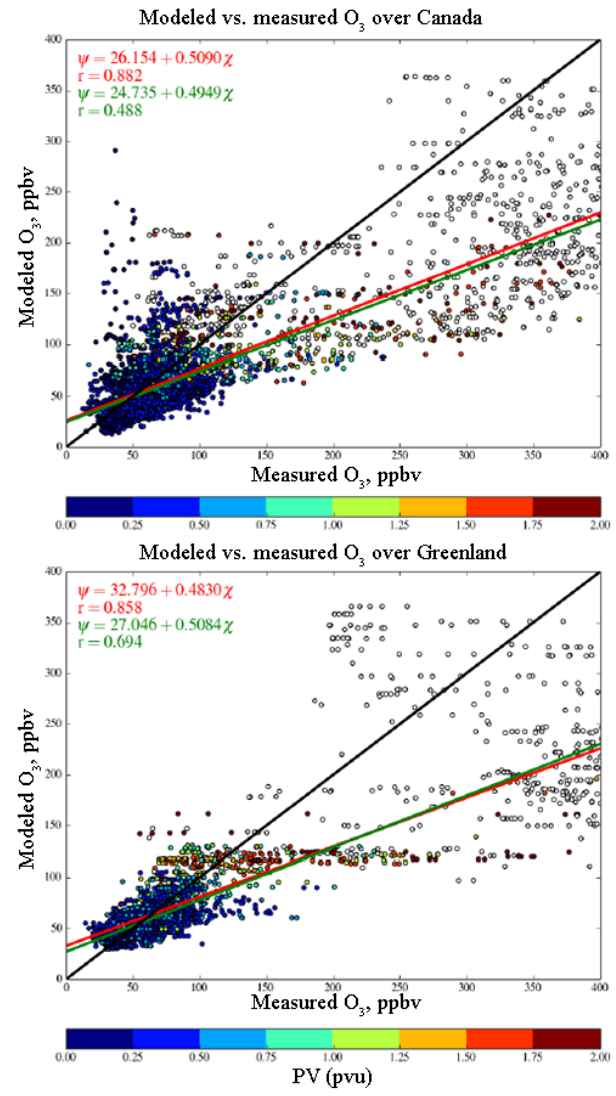
Figure 6. Scatter plot of WRF-Chem modeled vs. measured O 3 mixing ratio in ppbv for Canada (top panel) and Greenland (bottom panel) domains. The black lines are the one-to-one line and the PV color scale distinguishes stratospheric (red and white dots) and tro- pospheric data (blue and green dots). The regression line parameters and the Pearson correlation coefficient with its p value are colored in red and green for the PV range 0–4 and 0–1PVu, respectively.